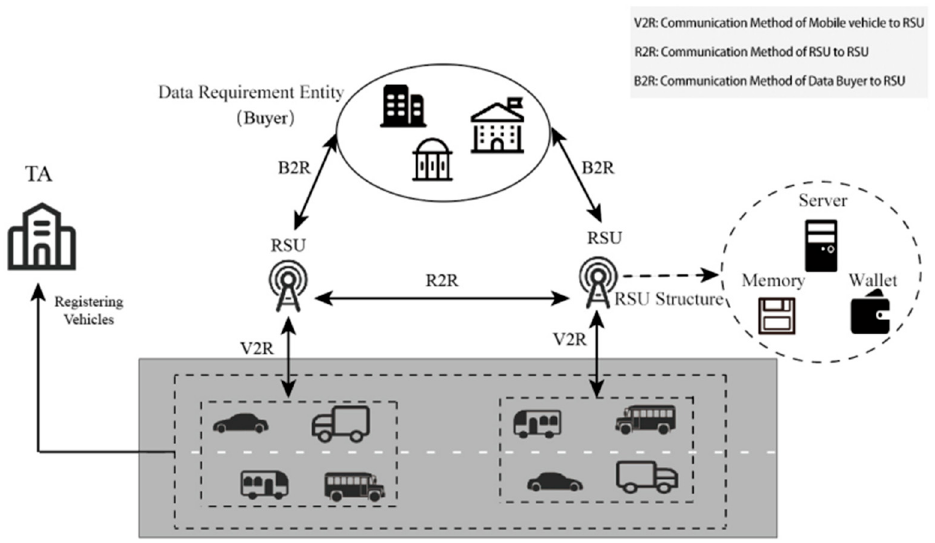
Figure 1. Diagram of system model.